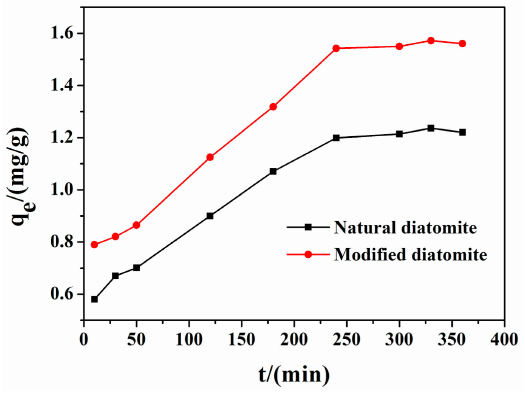
Figure 5. Diatomite adsorption 1-naphthol time versus adsorption